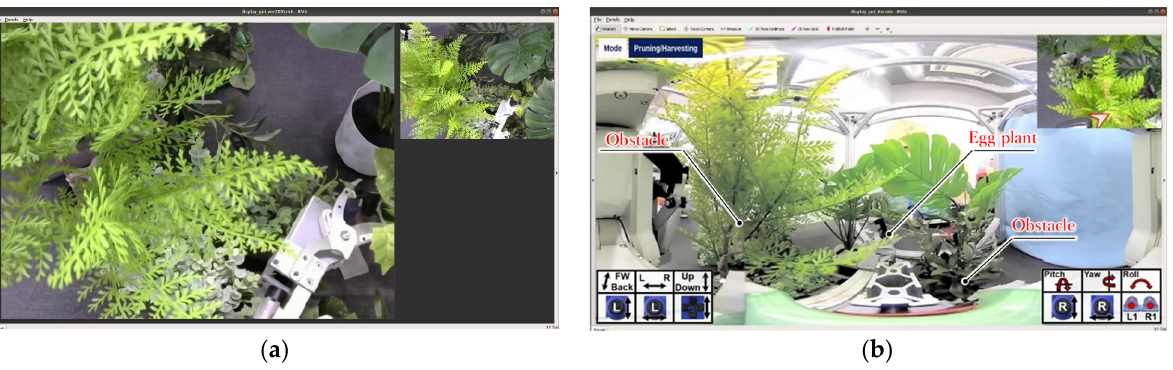
Figure 20. ( a ) Presented image with system A, ( b ) Presented image with system B. Presented images at the completion of harvesting in the three-task continuous operation. Red characters were not shown to an operator.